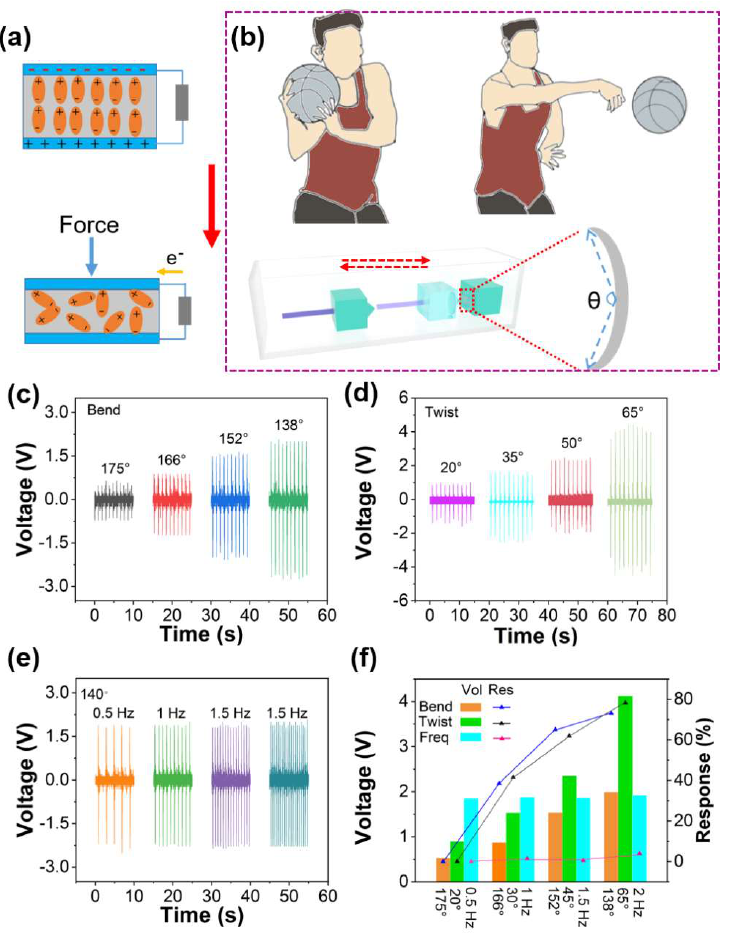
Figure 2. ( a ) Working mechanism of TSB-PENG; ( b ) Scene of TSB-PENG monitors the body joint motion system; ( c ) Outputting piezoelectric voltage of TSB-PENG at the same frequency and different bend angles; ( d ) Outputting piezoelectric voltage of TSB-PENG at the same frequency and different twist angles; ( e ) Outputting piezoelectric voltage of TSB-PENG at the same bend angle and different frequencies; ( f ) Response of output piezoelectric voltage of TSB-PENG at different bend angles, frequencies and twist